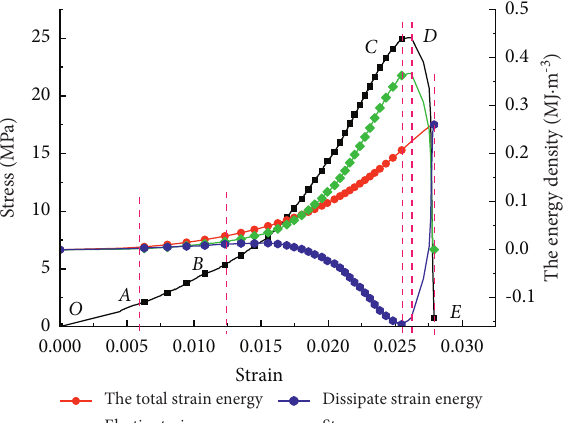
Figure 8: The relationship between stress, energy density, and strain under the uniaxial condition of rock sample with small pore